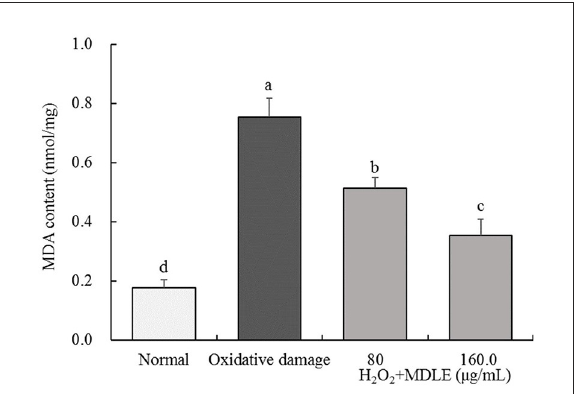
FIGURE4 MDA content of Malus doumeri leaf extract (MDLE) treatment on H 2 O 2 induced oxidative damage of H9C2 cells. a − d Lowercase letters are used to indicate significant differences at the P < 0.05 level. The same letter group indicates no difference, and the letter difference group indicates